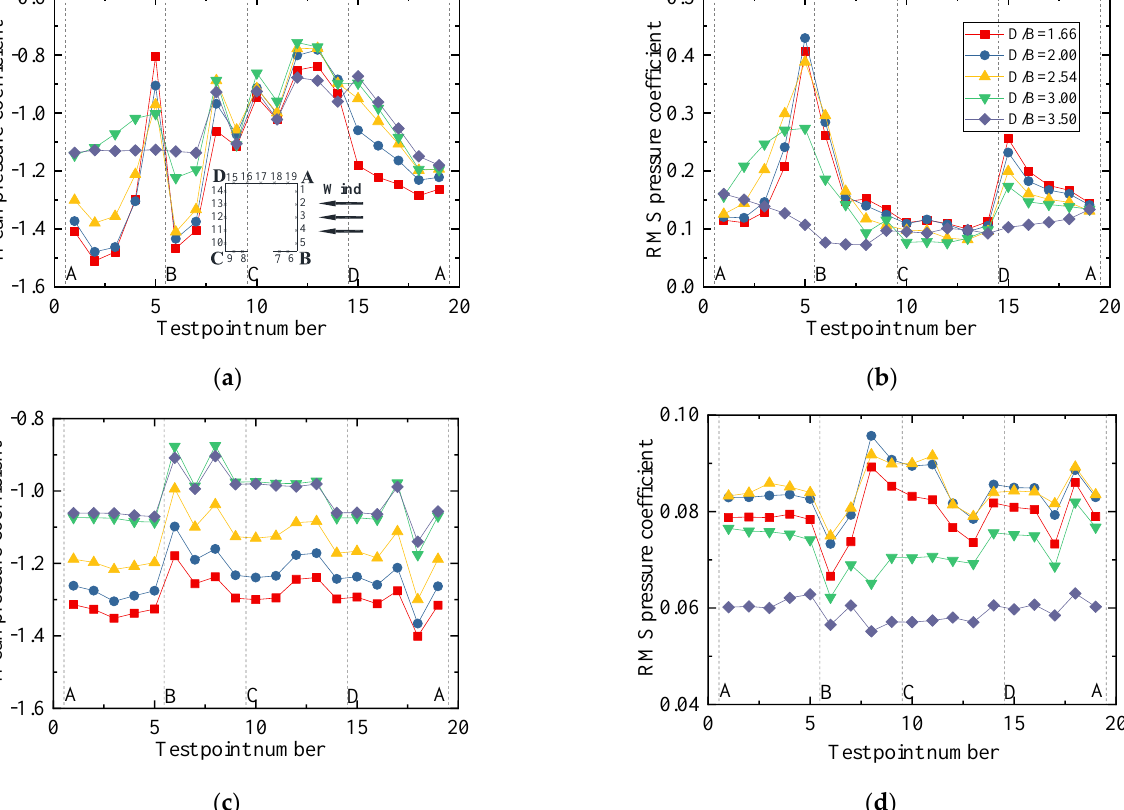
Figure 13. Wind pressure coefficients of the downstream bridge for Case 2: ( a ) Mean values of the outer taps; ( b ) RMS values of the outer taps; ( c ) Mean values of the inner taps; ( d ) RMS values of the inner taps.